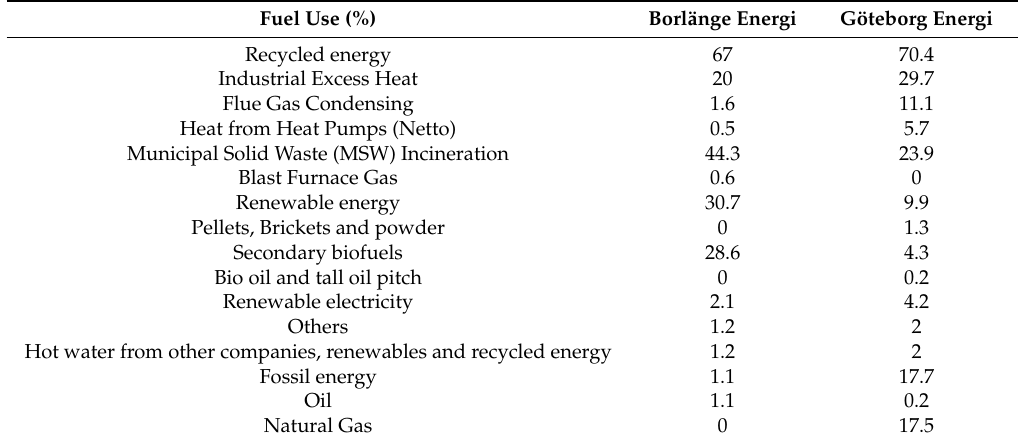
Table 6. Fuel use (%) for DH 2016 [38].